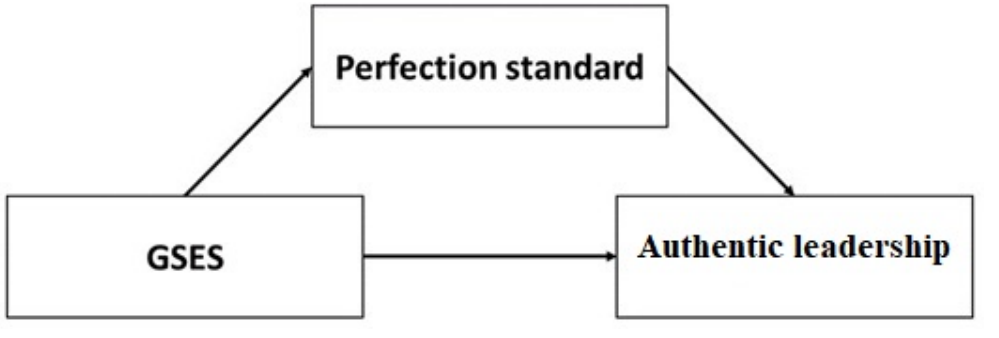
Figure 1. Theoretical model.